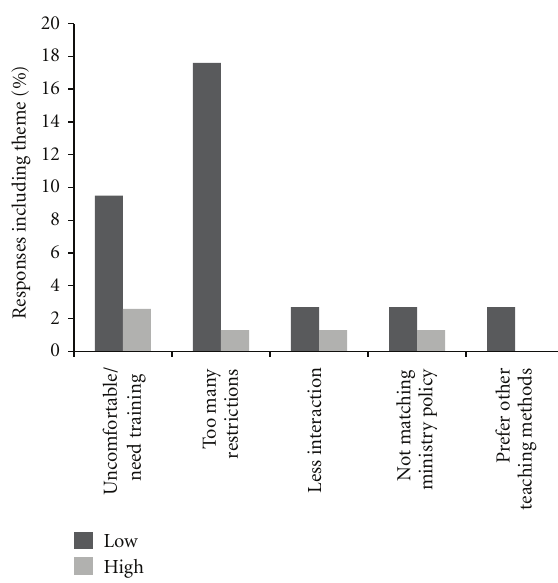
Figure 4: Patterns of themes integration level for integration of computer technology not fitting within personal instructional